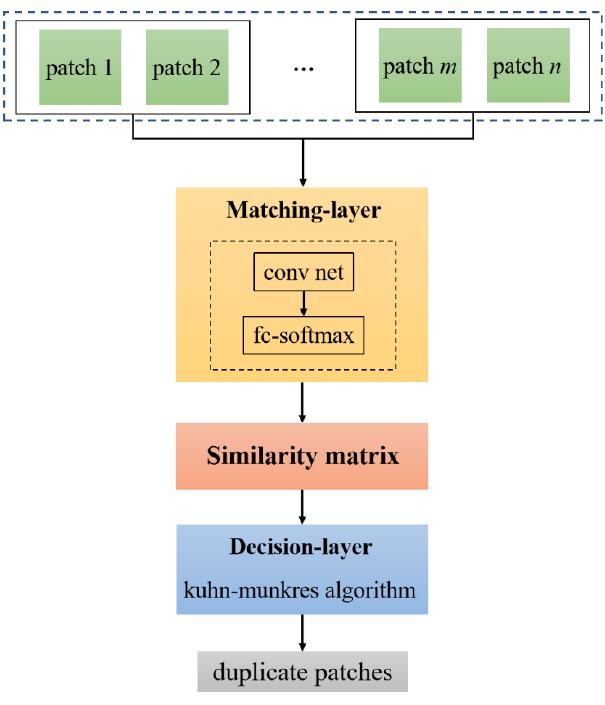
Figure 6. The workflow of the fruit matching model.